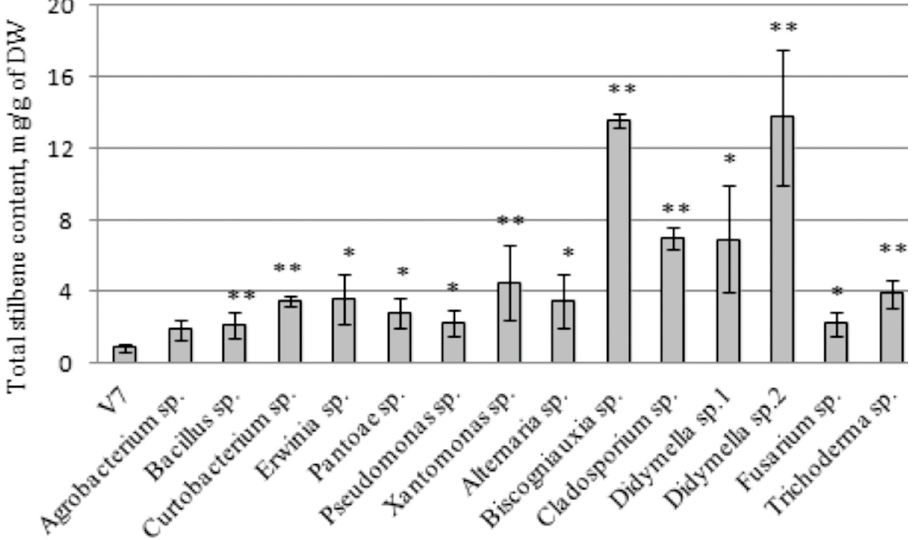
Figure 2. The total stilbene content (mg/g of the cell dry weight (DW)) in the V7 cell suspension culture of Vitis amurensis V7 after 3 days cocultivation with endophytic bacteria or fungi. * p < 0.05; ** p < 0.01 versus values of stilbene accumulation in the V7 cell cultivated under control conditions without bacteria and